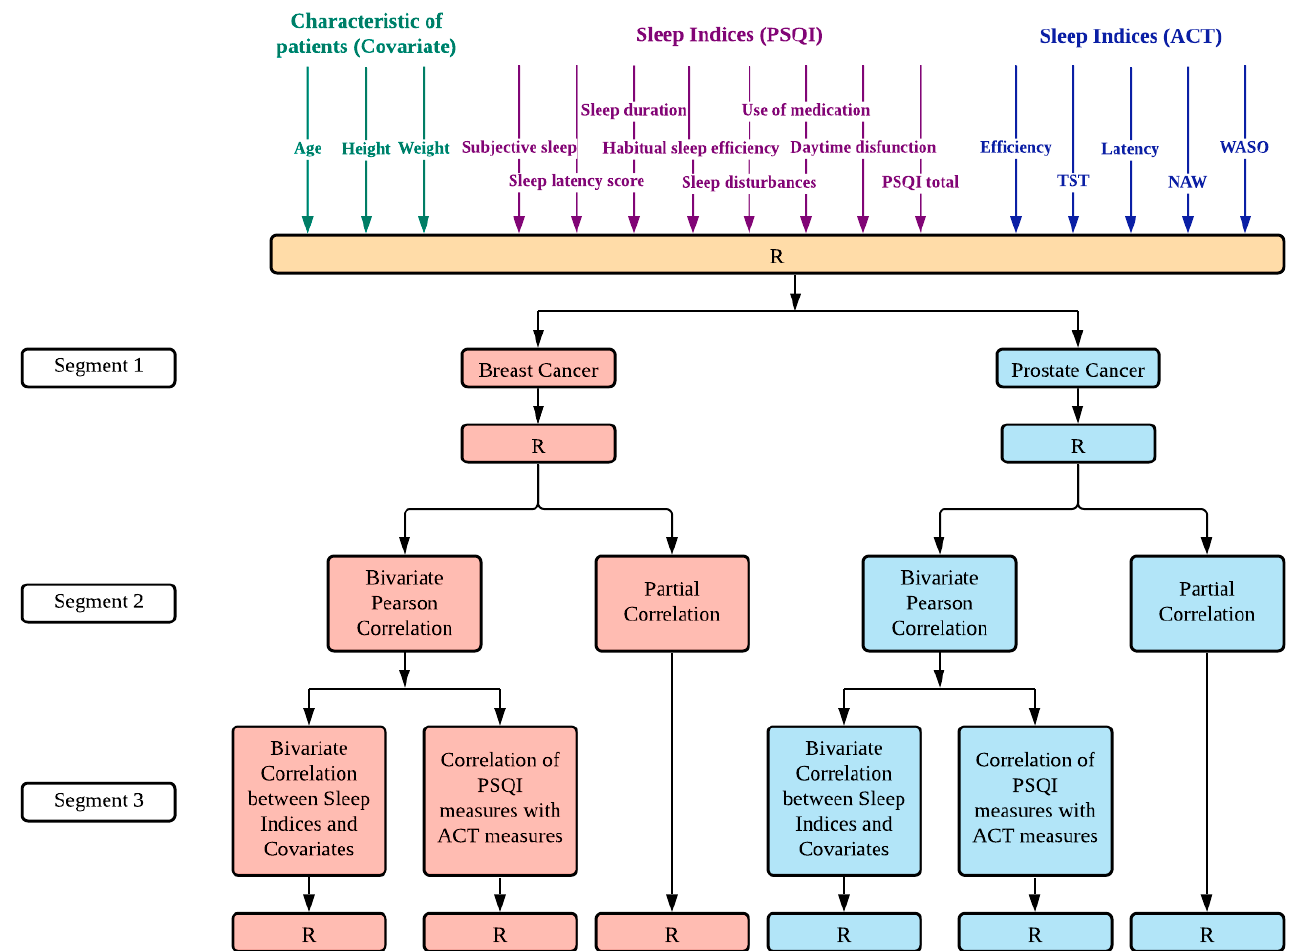
Figure 2. Step-by-step pipeline from data collection to obtaining results for correlation analysis. Segment 1: Dataset consisted of variables that included the characteristics of patients, sleep indices measured by PSQI, and sleep indices measured by actigraphy. The collected data was divided into breast cancer and prostate cancer datasets. Segment 2: We conducted bivariate Pearson correlation and partial correlation for each dataset. Segment 3: Bivariate Pearson correlation analysis resulted in the bivariate correlation between sleep indices and covariates, and correlation of PSQI measures with actigraphy measures. R—Result, after variables selection or statistical analysis.